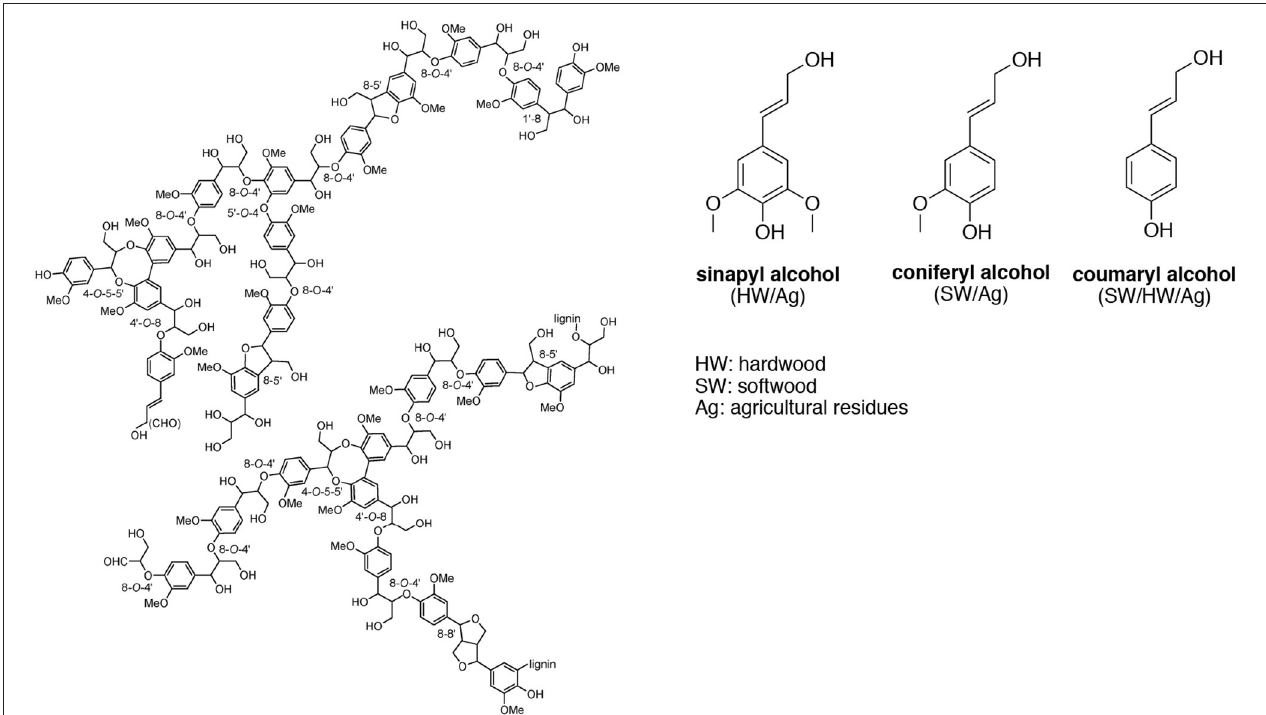
FIGURE 1 | Three phenyl propane precursors of lignin and illustration for SW lignin. (DOE,